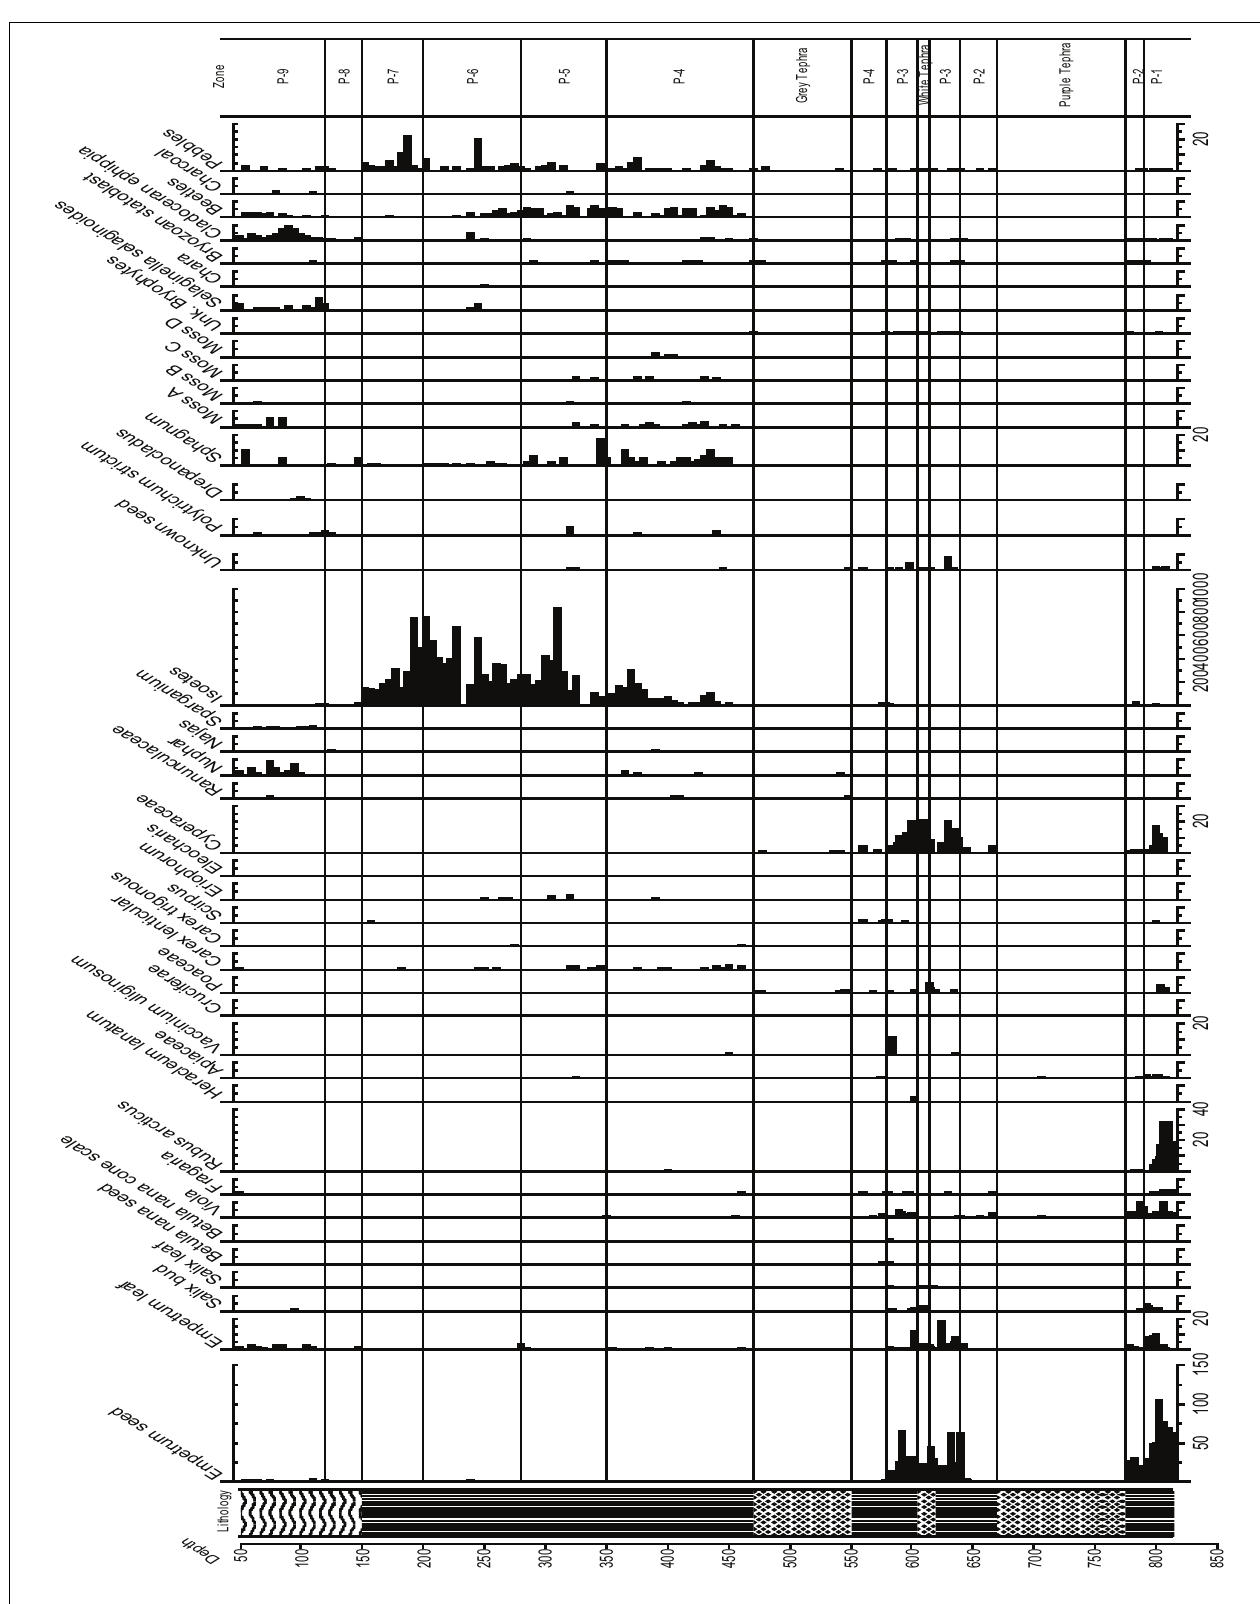
FIGURE 7 | Macrofossil diagram from Phalarope Pond, Kodiak Island.